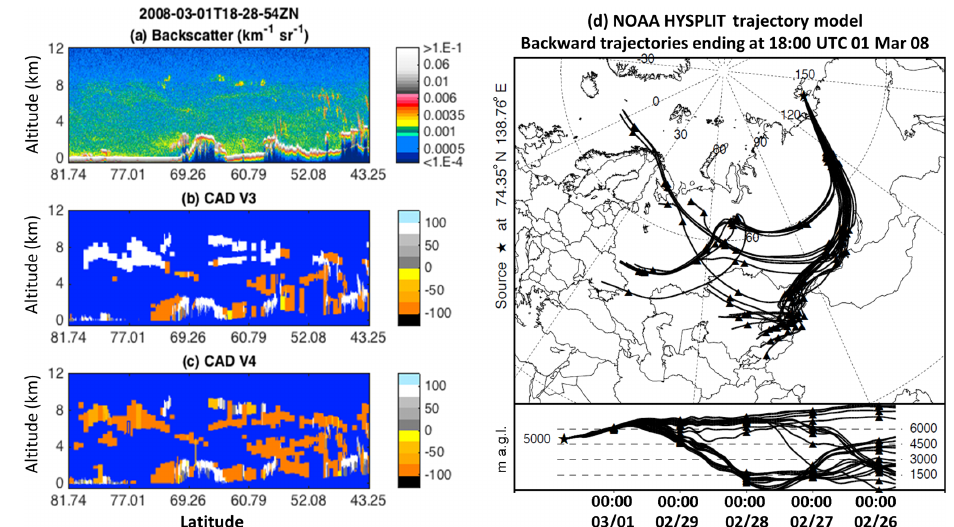
Figure 13. (a) V4 532nm attenuated backscatter coefficients, (b) V3 CAD scores, and (c) V4 CAD scores for the granule 2008-03-01T18- 28-54ZN between 43 and 81 ◦ N, and (d) NOAA HYSPLIT back trajectories starting at 74.35 ◦ N, 138.76 ◦ E.